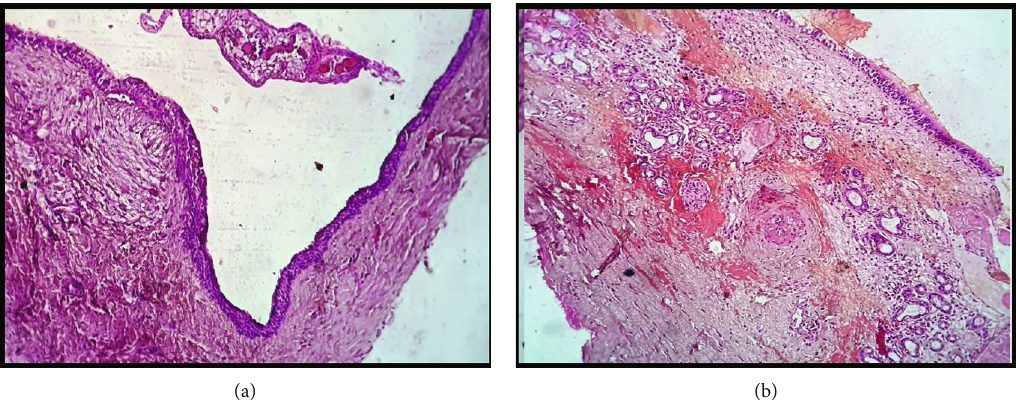
Figure 4: (a) and (b) Epithelial lining showing a combination of pseudostrati fi ed ciliated columnar and nonkeratinized strati fi ed squamous epithelium varieties, with mucous glands and neurovascular bundles in the cystic wall (H&E stain, 100 ×